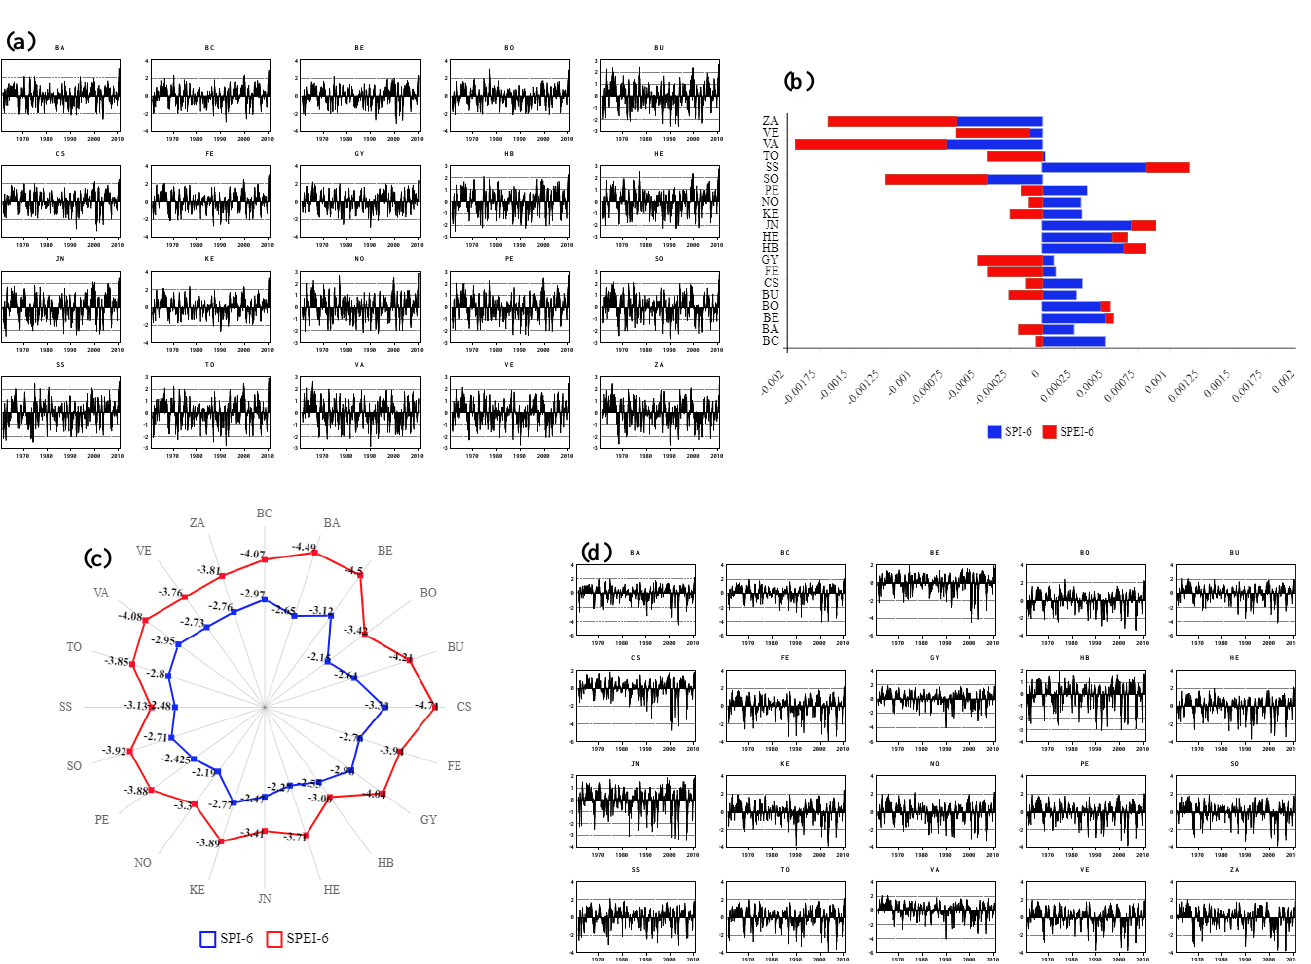
Figure 4. Ag.D evolution across Hungary (1960–2010): ( a ) Evolution of SPI-6 across Hungarian counties (1960–2010); ( b ) trends in SPI-6 and SPEI-6 based on MK tests and Sen slopes; ( c ) lowest recorded values of SPI-6 and SPEI-6 across Hungarian counties (1960–2010); ( d ) Evolution of SPEI-6 across Hungarian counties (1960–2010).